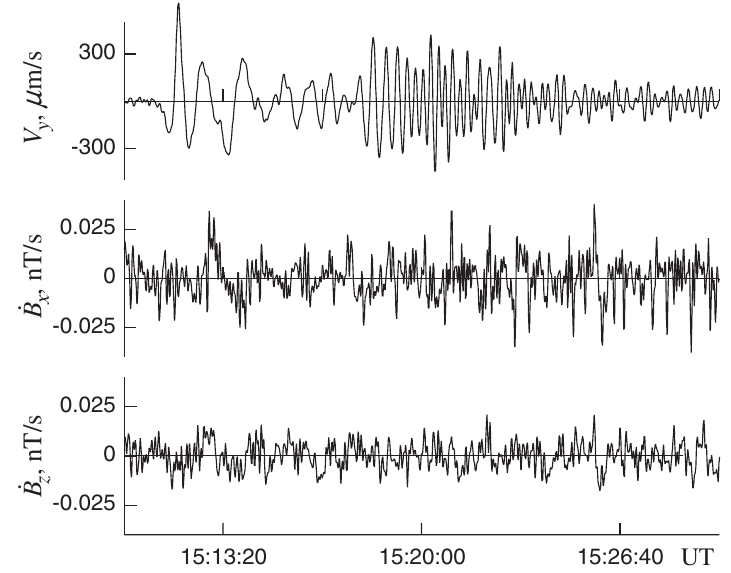
Fig. 2. Seismic waves and magnetic oscillations recorded at the Talaya Station and the Mondy Observatory, re- spectively, on June 18, 2000. Here, V y is the transverse component of the displacement velocity, and B are the horizontal and vertical components of the magnetic field, where dots mean the differentiation with re- spect to time. The coordinate system is oriented in such a way as to make the x -axis parallel to the arc of the great circle that passes through the earthquake epicenter (see